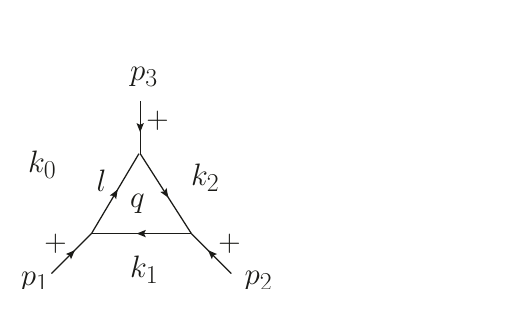
Figure 18 . The (+++) triangle one-loop diagram. q is the region momentum associated with the loop and k These are related to the region momenta via: l = q − k